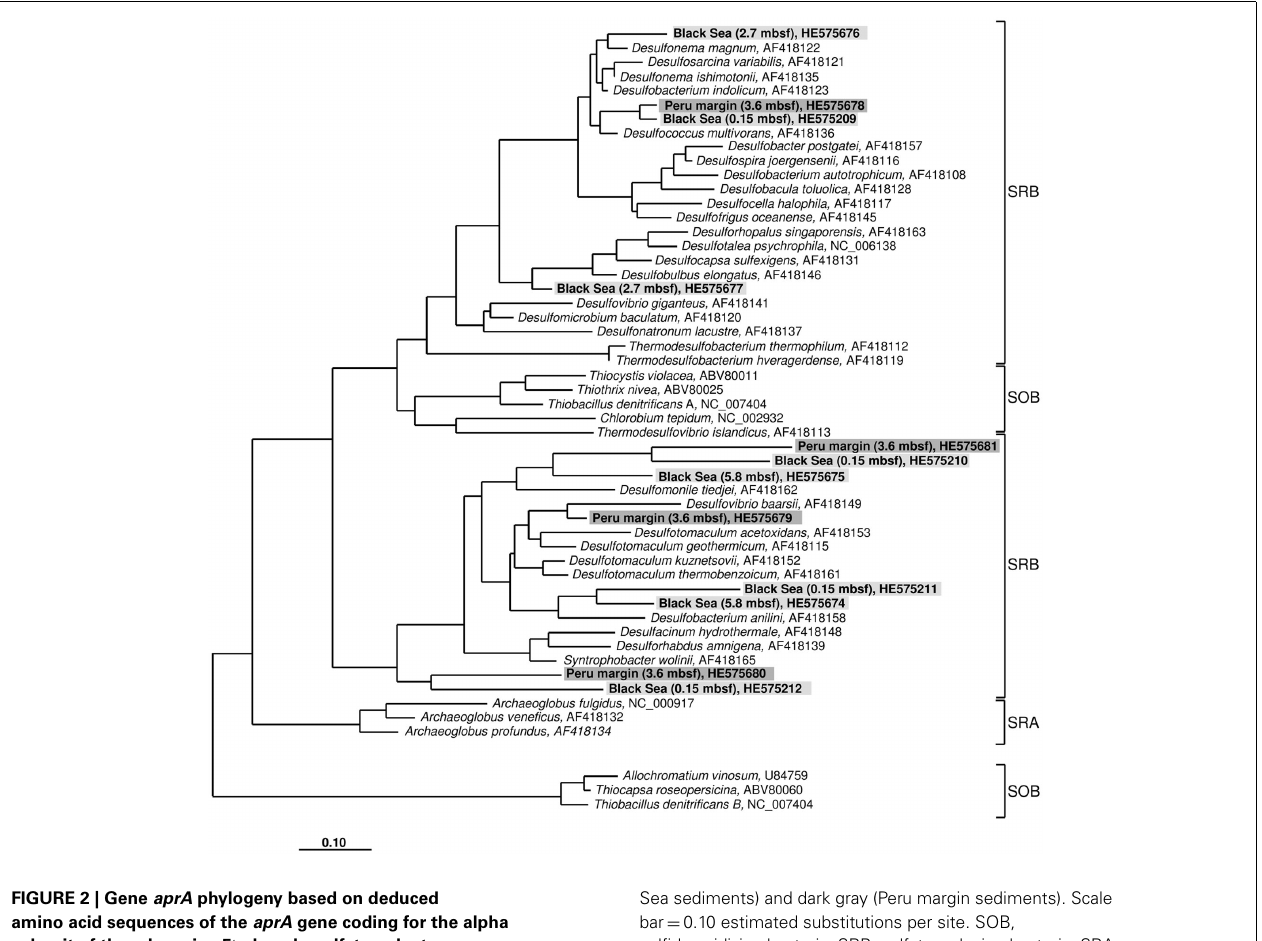
Sea sediments) and dark gray (Peru margin sediments). Scale bar = 0.10 estimated substitutions per site. SOB, sulfide-oxidizing bacteria; SRB, sulfate-reducing bacteria; SRA, sulfate-reducing